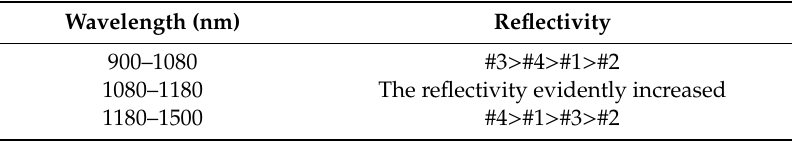
Table 10. Comparison of the reflectivity of four samples.